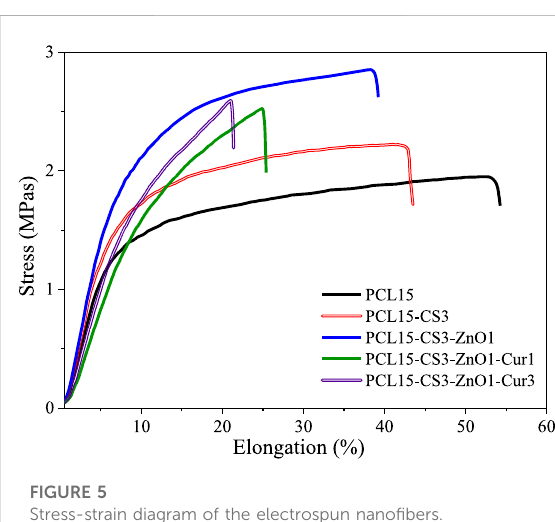
FIGURE 4 XRD pattern of Cur, ZnO, and the electrospun samples.